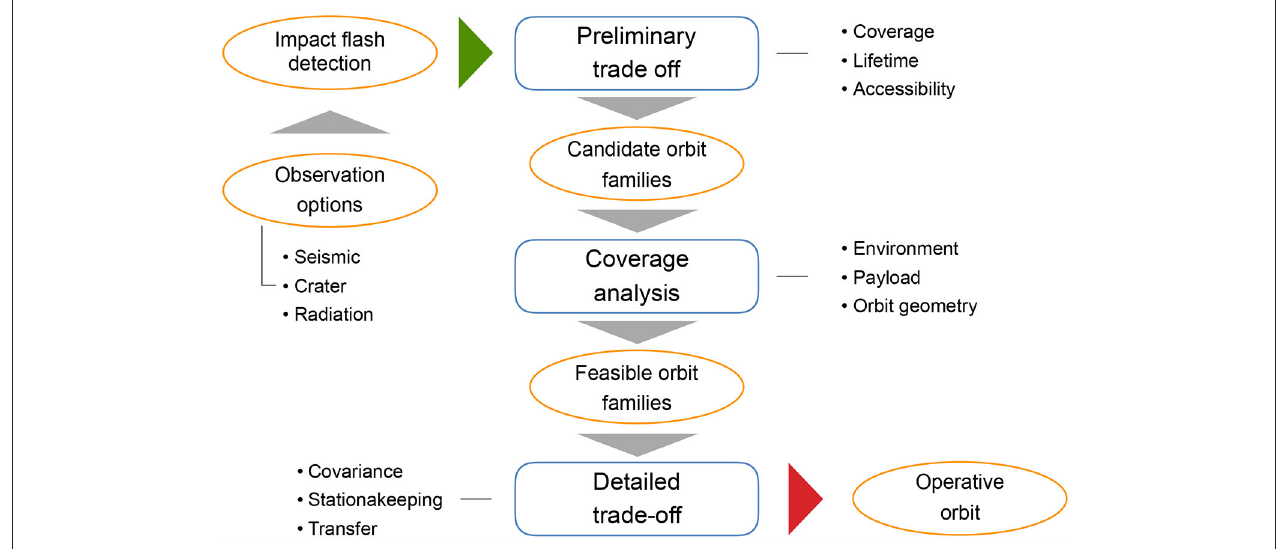
FIGURE 1 | Trade-off scheme for the selection of LUMIO operative